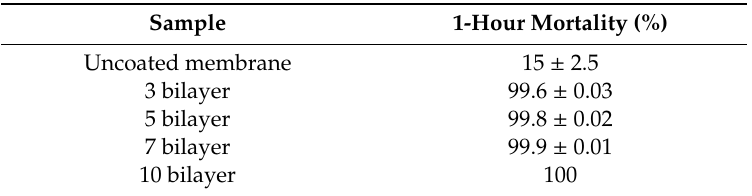
Figure 17. Water flux and salt rejection of 3-bilayer-coated polyamide membranes compared to un-coated membranes. Conditions: NaCl: 2000 ppm; pressure: 15.5 bar; temperature 25 ± 0.5 °C. pH was not provided. [268]. Reprinted with permission of Elsevier B.V. Table 12. Mortality of E. coli for coated and un-coated polyamide membrane after 1 h of exposure time. 10 9 CFU / m 2 incubation level. Adapted from [268]. Used with permission of Elsevier